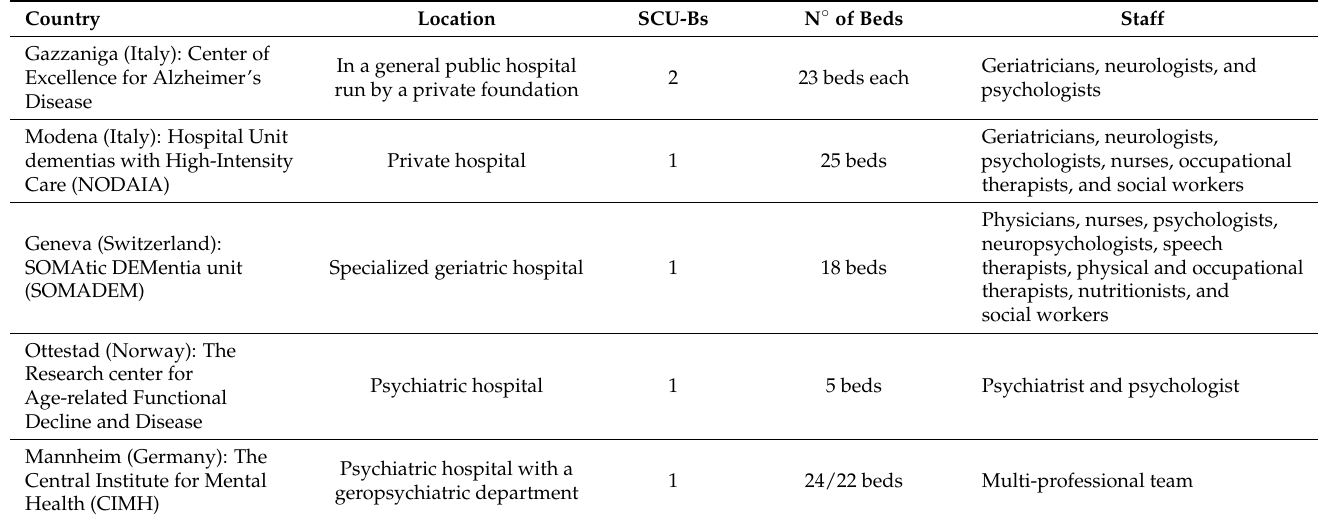
Table 3. Summary of how these SCU-Bs are set